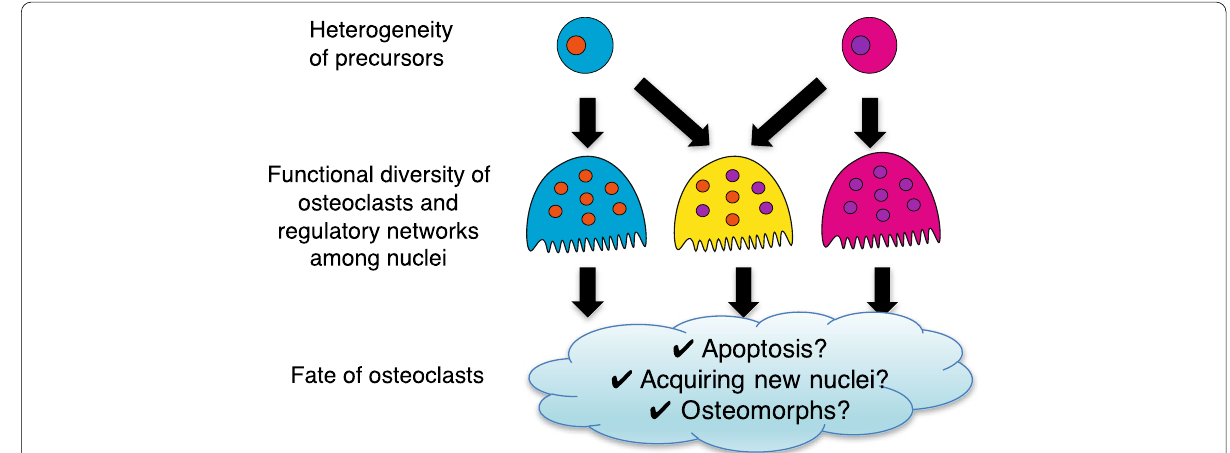
Fig. 4 Emerging mysteries in the osteoclast biology. Single-cell studies have provoked new questions in the osteoclast biology field. Osteoclast precursors may comprise different subsets depending on life stages and pathologies; however, functional difference among osteoclasts derived from distinct precursors remains unclear. Given that osteoclast precursors can fuse one another to differentiate into osteoclasts, it will be important to elucidate the regulatory mechanisms of the multinuclear system to understand the functional diversity of osteoclasts. Although osteoclasts are thought to die quickly by apoptosis after resorbing bone, novel hypotheses regarding the fate of osteoclasts have emerged. Further studies are needed to draw a comprehensive picture of osteoclast life cycle and its functional diversity in health and